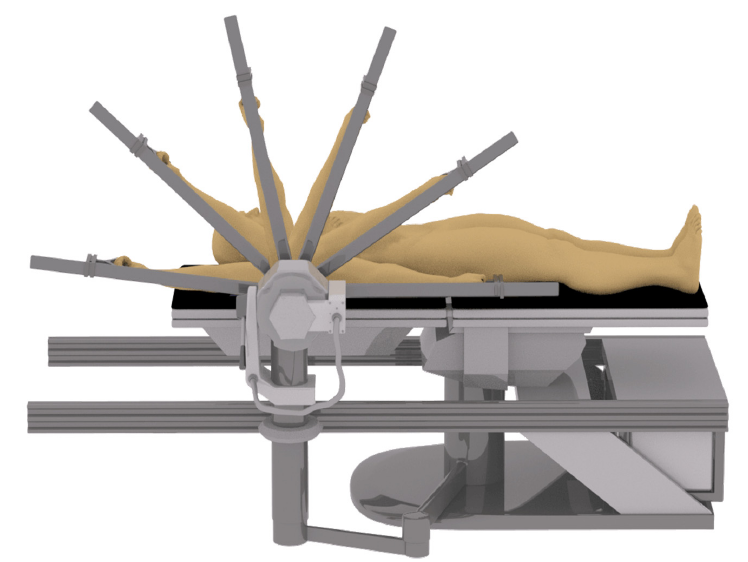
Figure 2. Shoulder adduction/abduction isokinetic motion.